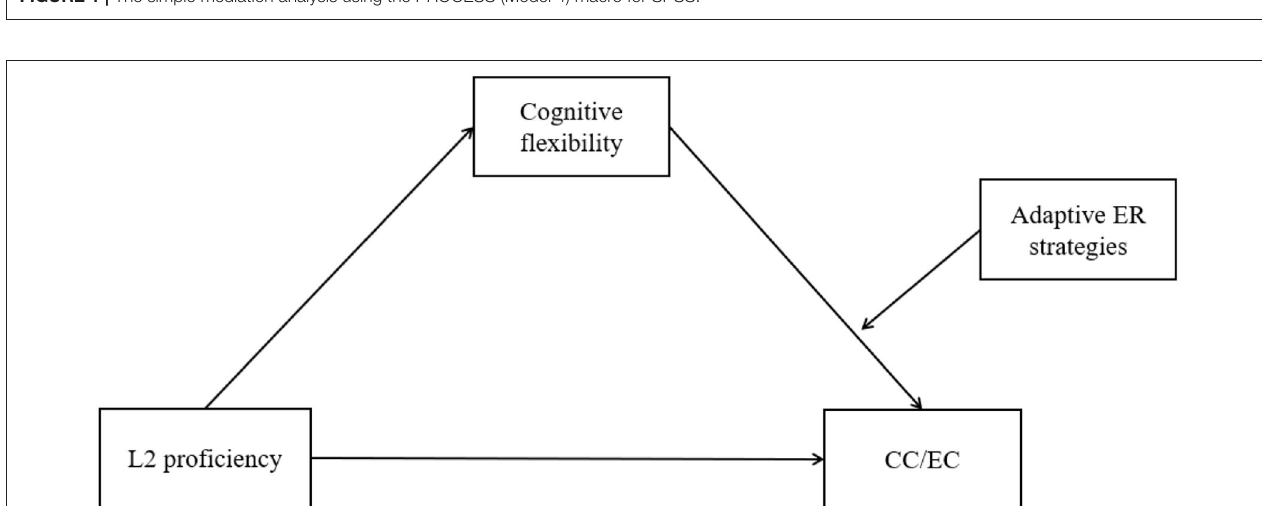
FIGURE 1 | The simple mediation analysis using the PROCESS (Model 4) macro for SPSS.